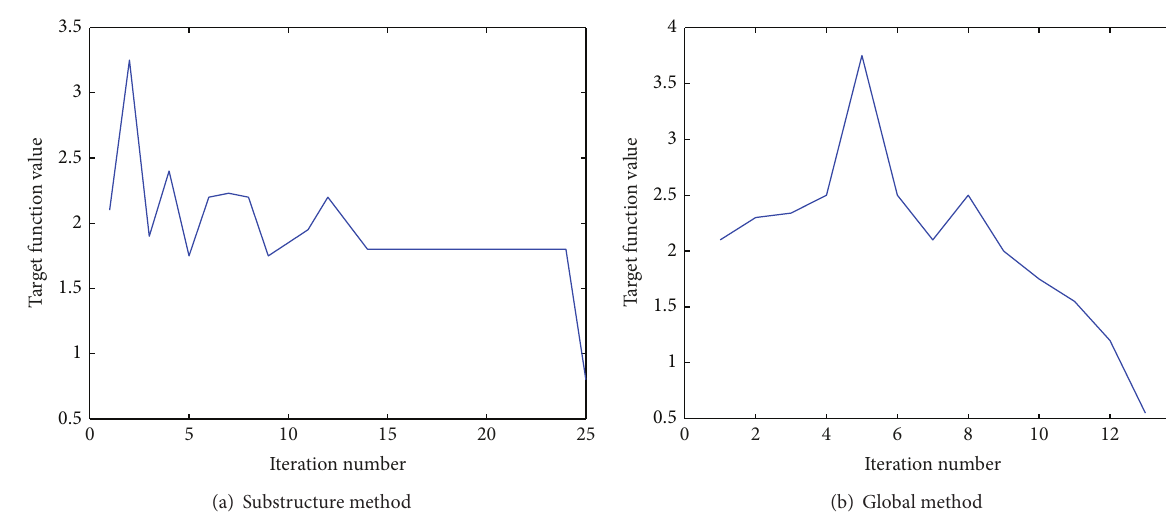
Figure 8: Convergent curves of Case